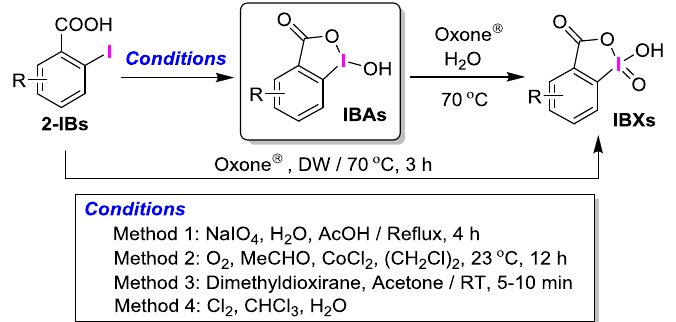
Figure 2. Synthesis of 2-iodosobenzoic acids (IBAs) and 2-iodoxybenzoic acids (IBXs) from 2-iodo- benzoic acids (2-IBs).